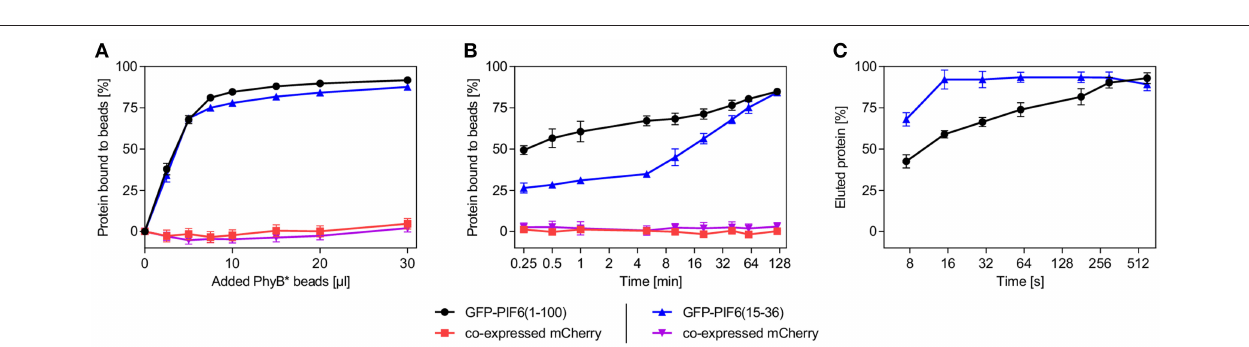
FIGURE 3 | Characterization of the light-controlled affinity purification system. Lysates of HEK-293T cells containing mCherry and GFP-PIF6(1-100) or GFP-PIF6(15-36) as described in Figure 2A were used. (A) Binding efficiency and capacity of PhyB* beads. Different amounts of PhyB* beads were each incubated with 250 µ l of cell lysate containing 1.5 nmol GFP-PIF6(1-100) or GFP-PIF6(15-36) for 2h at 660nm illumination. Afterwards, the ratio of bound protein was determined by measuring fluorescence of unbound GFP and mCherry. (B) Binding kinetics. Equal amounts of PhyB* beads (20 µ l) were incubated with 125 µ l of cell lysate containing 0.75 nmol of GFP-PIF6(1-100) or GFP-PIF6(15-36) for the indicated time periods under 660nm light. Subsequently, the ratio of bound protein was determined by measuring fluorescence of unbound GFP and mCherry. (C) Elution kinetics. Equal amounts of PhyB* beads (40 µ l) were incubated with 500 µ l of cell lysate containing 3.0 nmol of GFP-PIF6(1-100) or GFP-PIF6(15-36) for 1h at 660nm illumination. After washing, the beads were incubated in 500 µ l of wash buffer for the indicated times at 740nm light for elution. The percentage of eluted protein was calculated by determining GFP fluorescence in the supernatant in comparison to the GFP amount on the beads before elution. All data are means ± s.d. ( n =